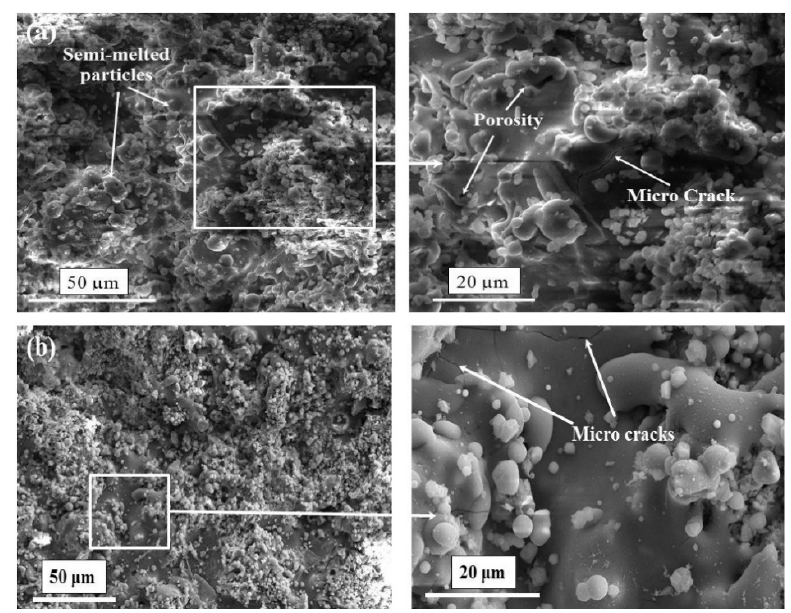
Figure 6. Morphology of HA-Zirconia coating stainless steel 316L substrate at different magnifications ( a ) as-sprayed ( b ) heat treated [99]. Table 2. Comparison between characteristics of different modes of plasma spray coating.